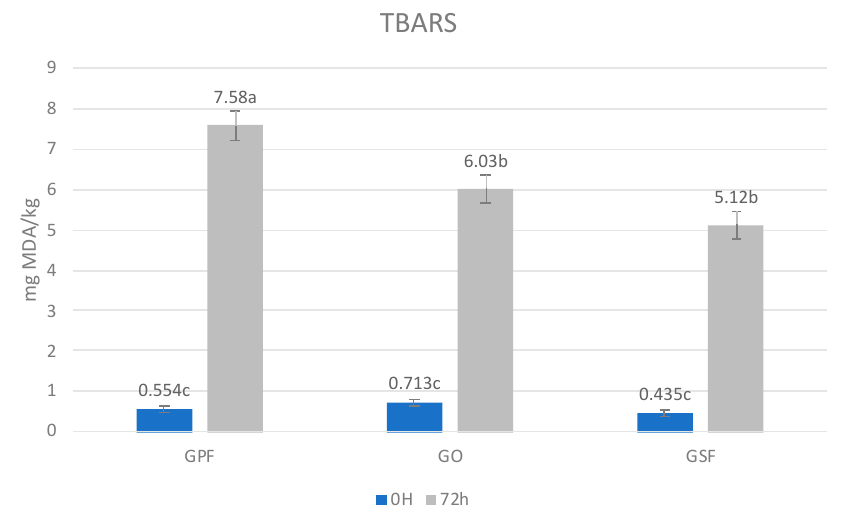
Figure 2. TBARS (mg MDA/kg of sample) of cooked goat meat burgers at 0 h and 72 h (Standard Error of Mean ± 0.351, Significance: 0.009, a–c mean values shown in bars not followed by a common letter differ significantly ( p < 0.05; Tukey test). Table 5. Volatile compound in HS of goat meat burger with fat replacement by